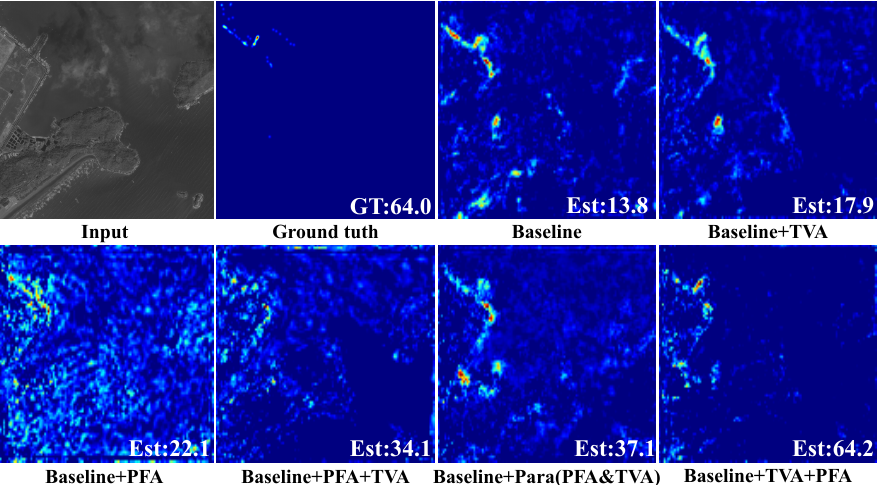
Figure 12. The qualitative comparison of the baseline with different